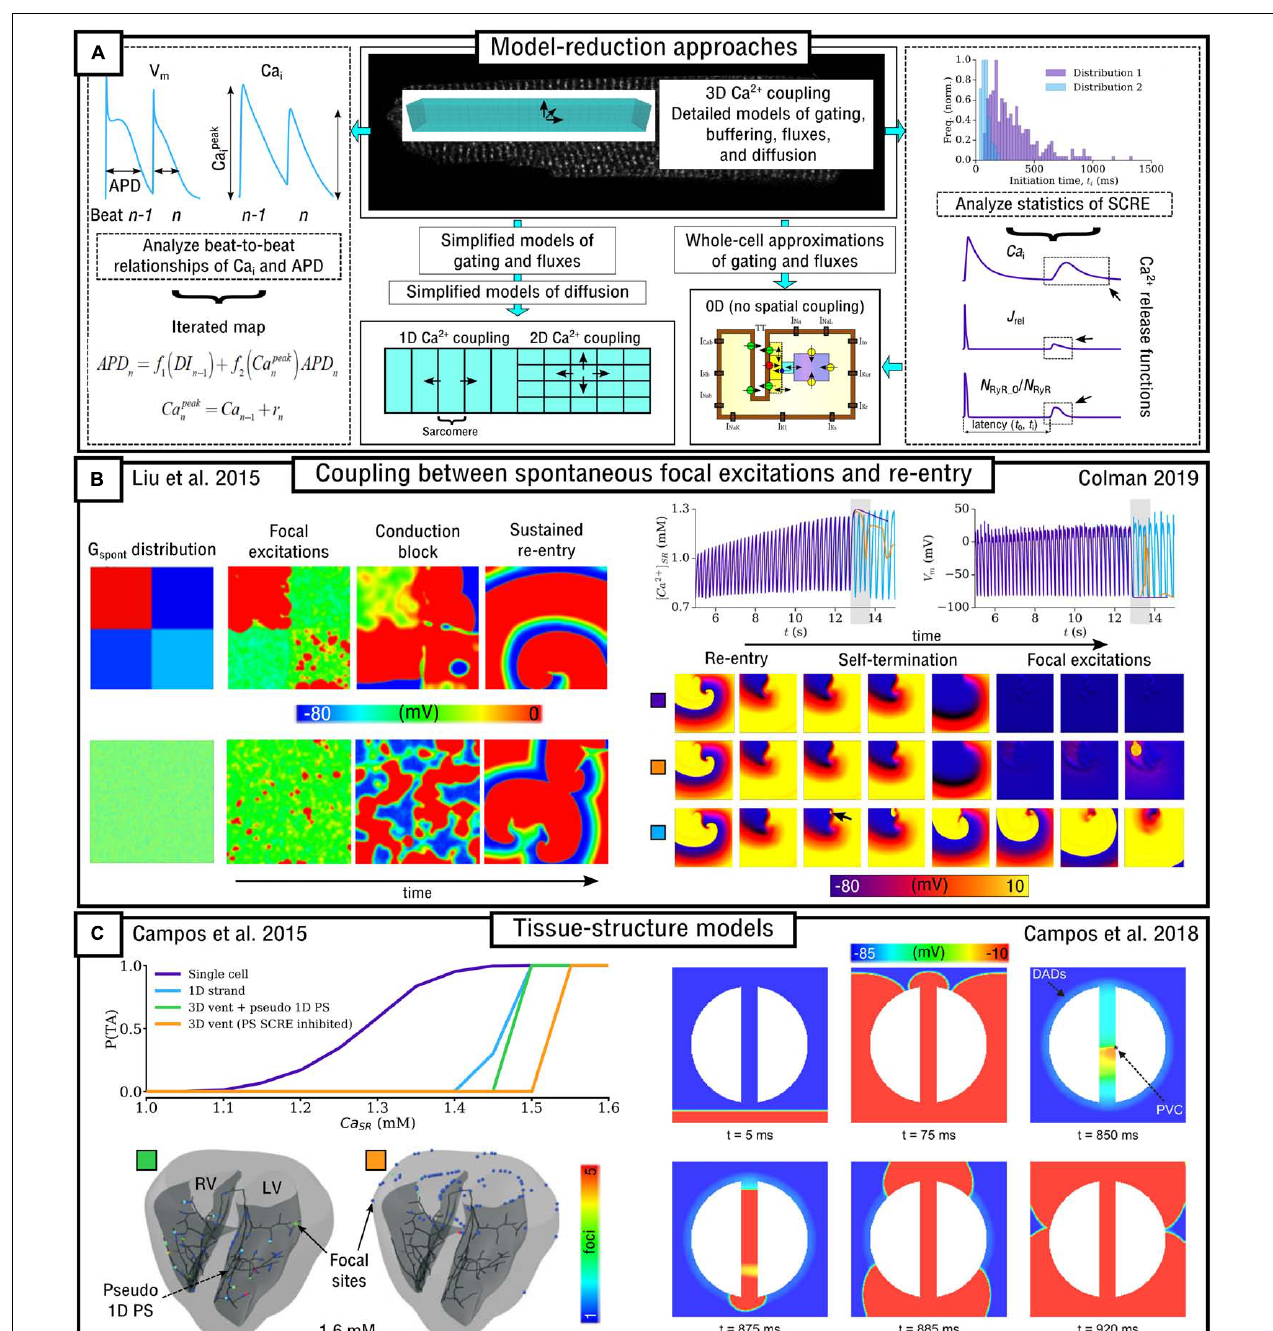
FIGURE 8 | Multi-scale modeling approaches. (A) Illustration of different approaches for reducing the computational intensity of models of sub-cellular Ca 2 + handling. The center, upper panel illustrates a fully detailed 3D cell model, with biophysically detailed descriptions of gating, fluxes and diffusion. Below this panel are illustrated mathematical approaches for model reduction, either resulting in simplified spatial models (left) or non-spatial models (right). The left-most panel indicates how analysis of AP and CaT dynamics on a beat-to-beat basis can lead to the development of a non-spatial, iterated map model. The right-most panel illustrates how analysis of SCRE statistics enables the parameterization of analytical Ca 2 + release functions which can be imposed in a traditional, non-spatial cell model. (B) Illustration of bi-directional coupling between focal excitations and re-entry. Left: spontaneous excitations interact with each-other to cause conduction block and re-entry, modified from Liu et al. (2015). Right: illustration of the emergence of focal excitations following self-termination after a period of re-entry, from Colman (2019). (C) Structurally detailed tissue models imeplementing SCRE. Left: probability of SCRE as a function of SR-Ca 2 + in single-cell and 1D, 2D, and 3D with or without the pseudo-1D Purkinje System (PS), with the locations of focal exictations shown in the lower panel, modified from Campos et al. (2015); right: demonstration of a focal excitation emerging within the isthmus of an infarct borderzone, modified from Campos et al. (2018).